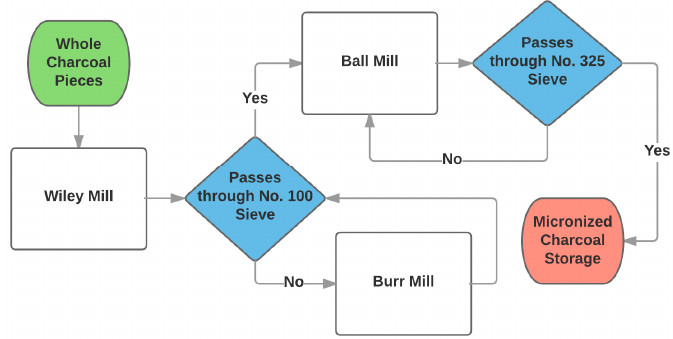
Figure 3. Multi-step milling process flow chart.